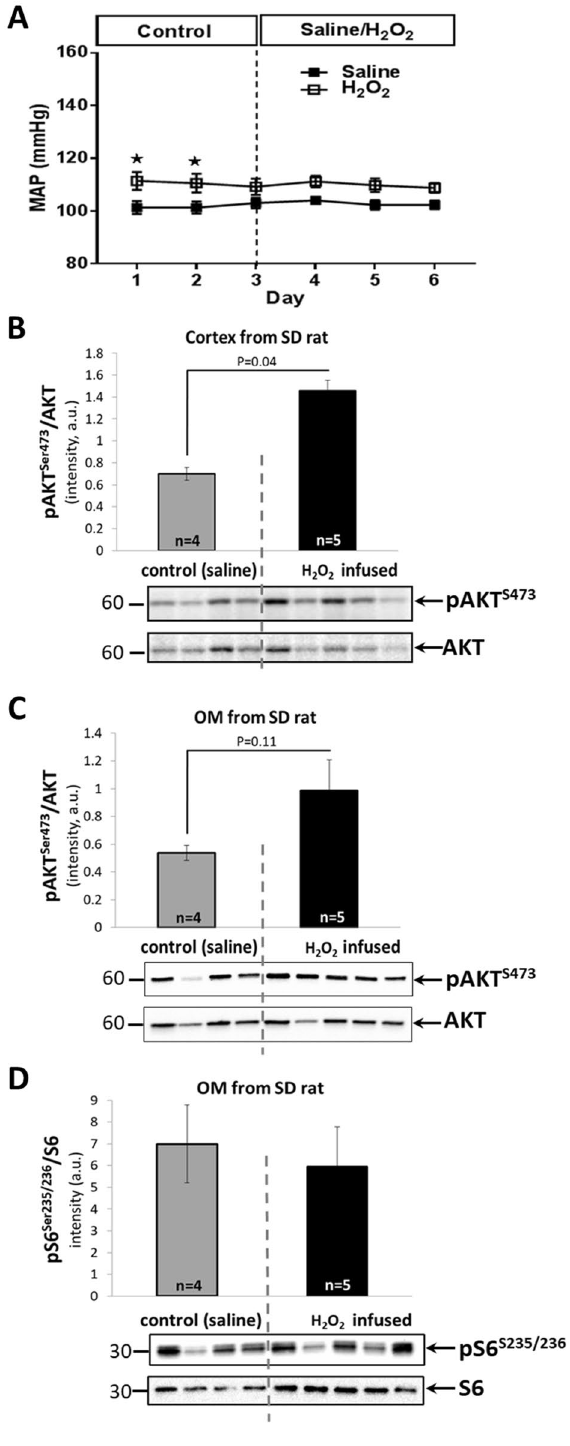
Figure 1. H 2 O 2 activates mTORC2 pathways in the absence of changes in blood pressure (BP). ( A ) Average 24 h mean arterial pressure (MAP) of single kidney SD rats (n = 9; fed 0.4% NaCl diet) with implanted renal interstitial infusion catheters receiving continuous infusion of isotonic saline (days 1–3) followed by infusion of H 2 O 2 (347 nmol/kg/min; open squares; n = 5) or continued infusion of saline (closed squares; n = 4). *—small but significant post-surgical differences between control groups on day 1 and 2 (determined by two-way analysis of variance (ANOVA) for repeated measures) were observed which converged to a similar stable BP after several days, at which time the H 2 O 2 infusion was begun. ( B , C ) Western Blot analysis of pAKT Ser473 and AKT proteins in renal cortical (Cortex, B) , outer medullar (OM, C) tissue and pS6 Ser235/236 and S6 proteins in OM tissue ( D ) homogenates of SD rats fed a 0.4% NaCl diet receiving a renal interstitial infusion of saline (gray bar; n = 4), or after 3 days of H 2 O 2 (347 nmol/kg/min; black bar; n = 5). * P < 0.05 value is shown; determined by Student’s